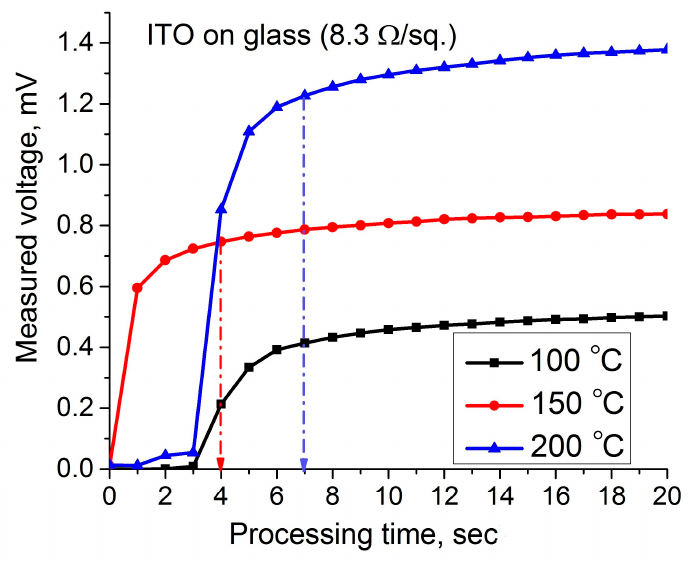
Figure 9. Dependence of the potential difference on the temperature.